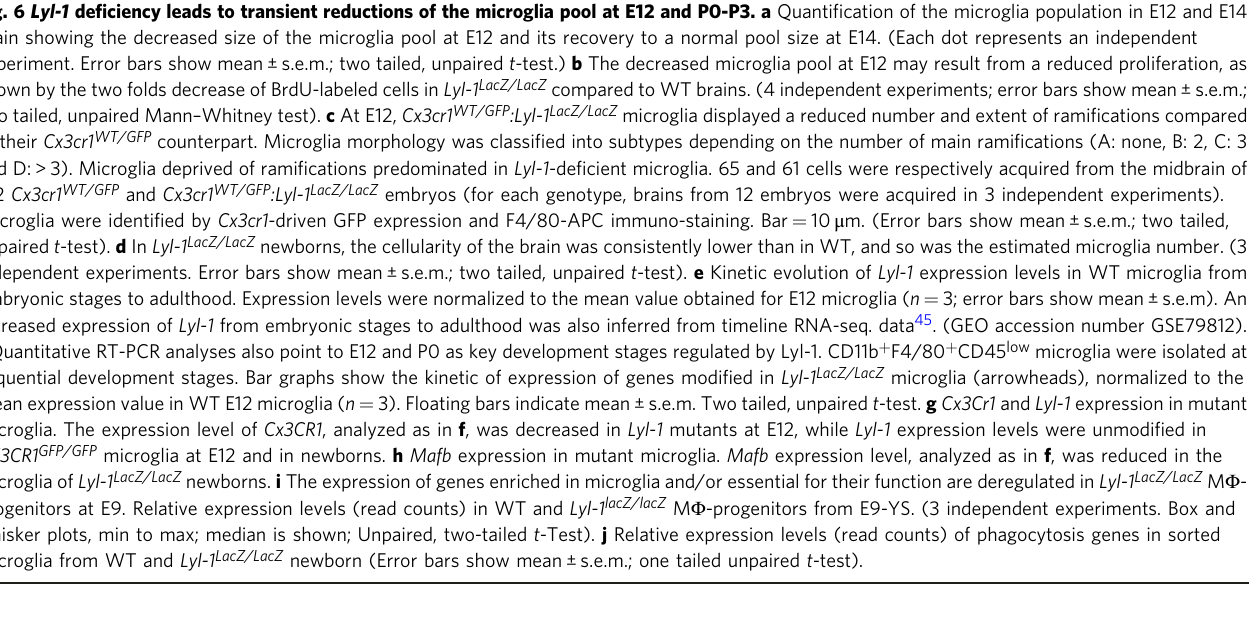
Fig. 6 Lyl-1 de fi ciency leads to transient reductions of the microglia pool at E12 and P0-P3. a Quanti fi cation of the microglia population in E12 and E14 brain showing the decreased size of the microglia pool at E12 and its recovery to a normal pool size at E14. (Each dot represents an independent experiment. Error bars show mean ± s.e.m.; two tailed, unpaired t -test.) b The decreased microglia pool at E12 may result from a reduced proliferation, as shown by the two folds decrease of BrdU-labeled cells in Lyl-1 LacZ/LacZ compared to WT brains. (4 independent experiments; error bars show mean ± s.e.m.; two tailed, unpaired Mann – Whitney test). c At E12, Cx3cr1 WT/GFP :Lyl-1 LacZ/LacZ microglia displayed a reduced number and extent of rami fi cations compared to their Cx3cr1 WT/GFP counterpart. Microglia morphology was classi fi ed into subtypes depending on the number of main rami fi cations (A: none, B: 2, C: 3